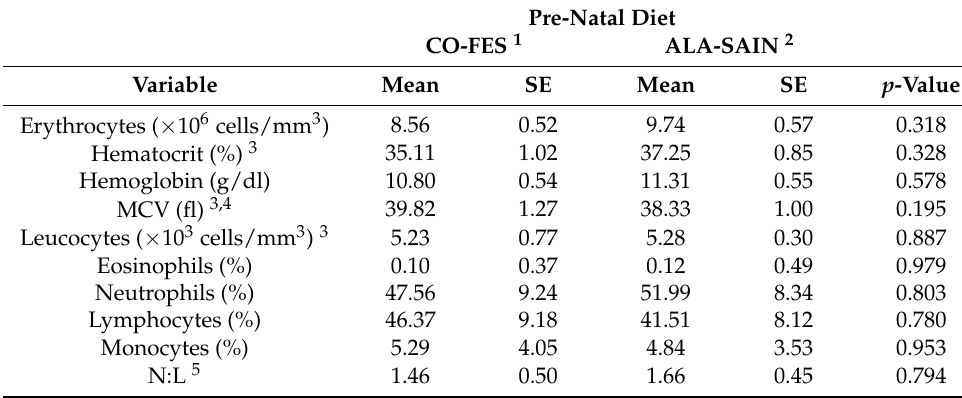
Table 1. Effect of pre-natal diet on hematological values of ewes right after birth. Pre-Natal Diet CO-FES 1 ALA-SAIN 2 Variable Mean SE Mean SE p